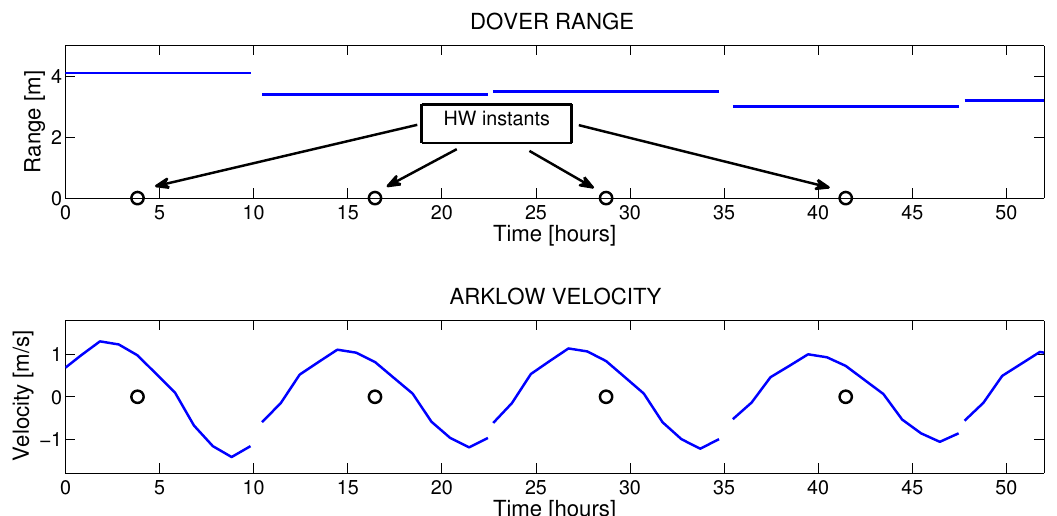
Figure 3. Water height range at Dover and calculated velocity at Arklow Bank (1st and 2nd of January